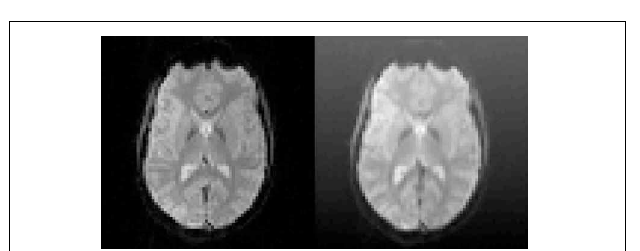
FIGURE 6 | Left: One slice of one fMRI dataset used for testing the motion correction algorithms. Right: The same slice after the application of a random translation and rotation, and addition of a shading (gradient) increasing upwards. The shading will affect all algorithms that use the image intensity directly. The phase based algorithm used in BROCCOLI will, however, not be affected by this shading. The main reason for this is that quadrature filters are bandpass filters, which remove low frequency variations (e.g., shadings) as well as high frequency variations (e.g., noise).